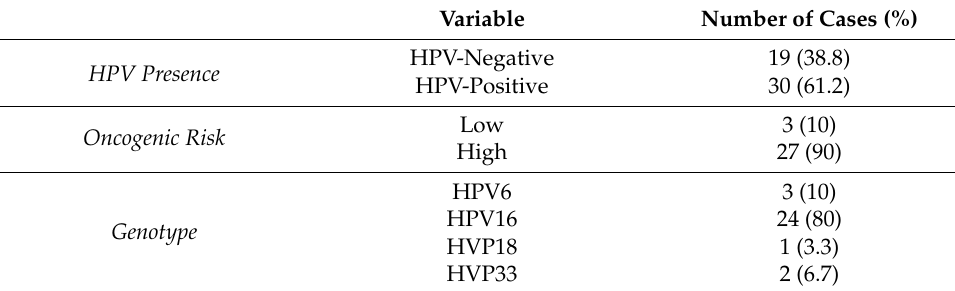
Table 2. HPV presence and genotypes in OPSCCs.